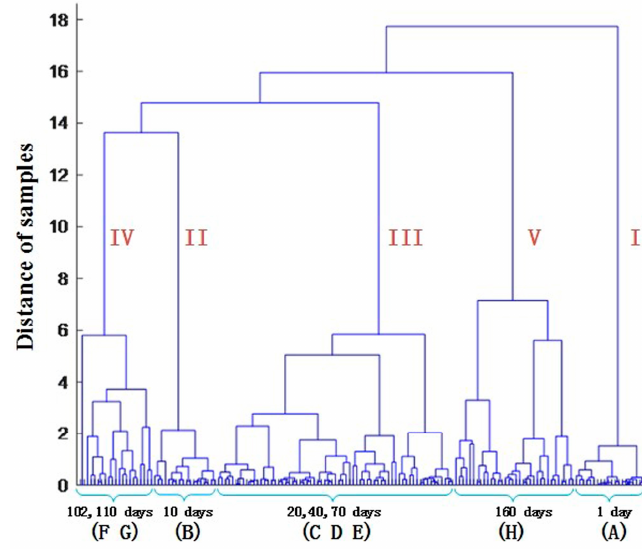
Figure 6. Clustering results of the oil samples.